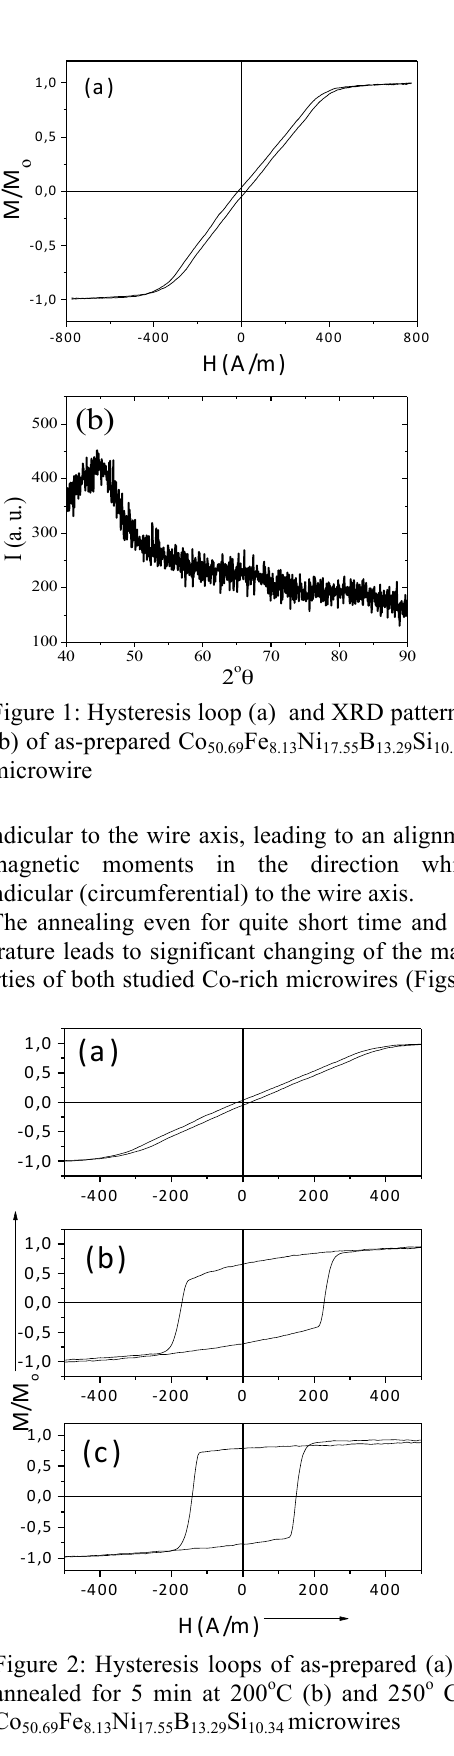
Figure 2: Hysteresis loops of as-prepared (a) and annealed for 5 min at 200 o C (b) and 250 o C (c) Co Fe Ni B Si 50.69 8.13 17.55 13.29 10.34